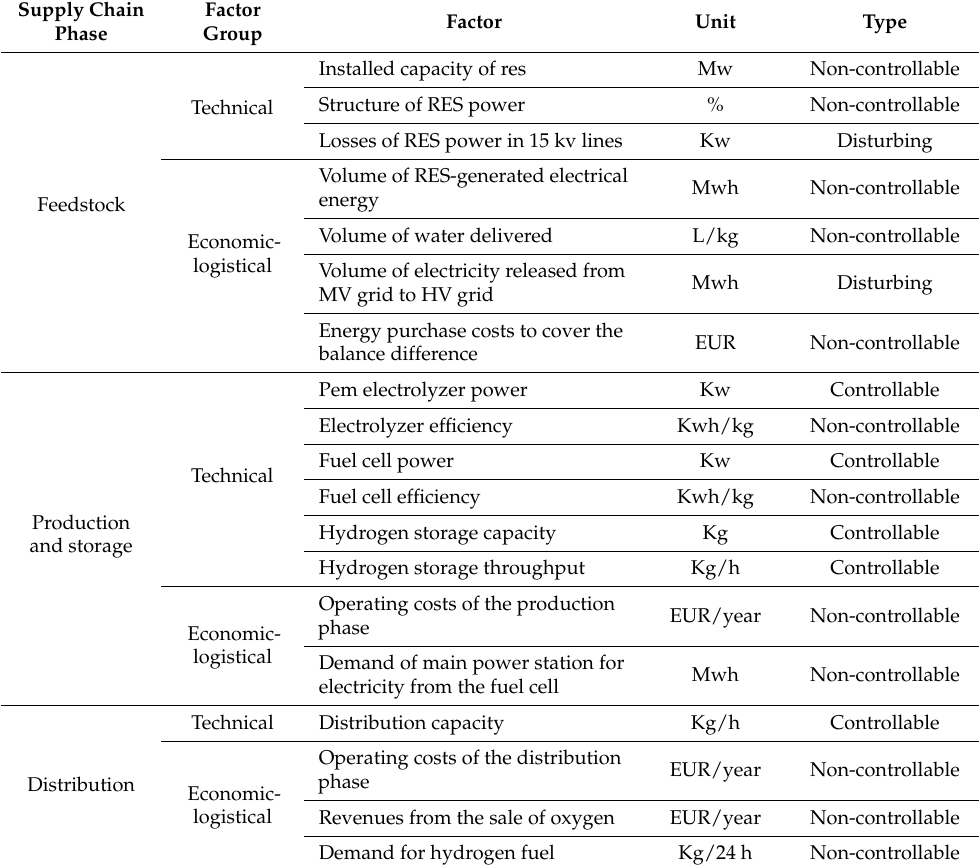
Table 2. Functional model factors derived from the conducted literature